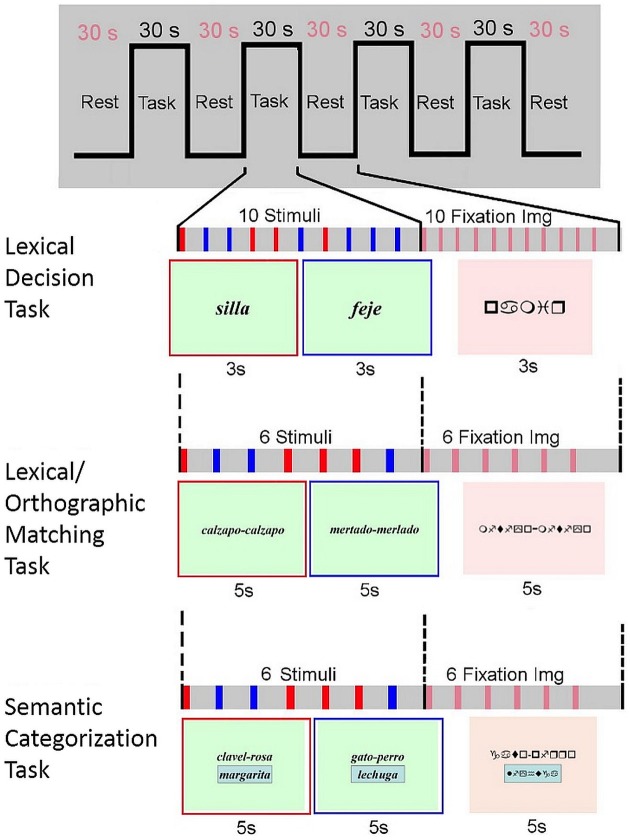
Experimental paradigm. For the reading blocks, in the lexical decision paradigm two kind of stimulus were visually presented, real words (e.g., silla, chair in Spanish), and pseudowords (e.g., feje, which means nothing in Spanish); in the lexical/orthographic matching paradigm two sets of two-syllable pseudowords were displayed simultaneously, either identical (e.g., calzapo-calzapo) or different (e.g., mertado-merlado); and in the semantic categorization paradigm the three words presented at the same time could be either from the same (e.g., clavel, rosa, and margarita; carnation, rose and daisy in Spanish) or from different (e.g., gato, perro, and lechuga; cat, dog and lettuce in Spanish) semantic categories.